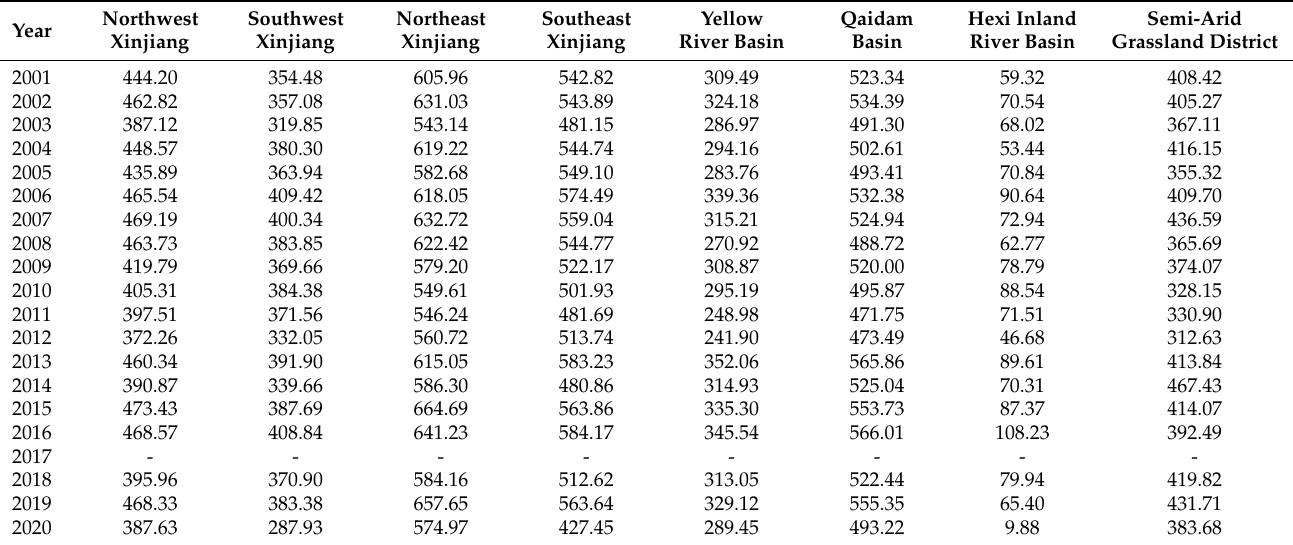
Water Lines’ region from 2001 to 2020 is shown in Figure 5. The above data are used to analyze the various characteristics of the IWR in the northwest ‘Three Water Lines’ area. Table 3. IWR in sub-regions of ‘Three Water Lines’ area from 2001 to